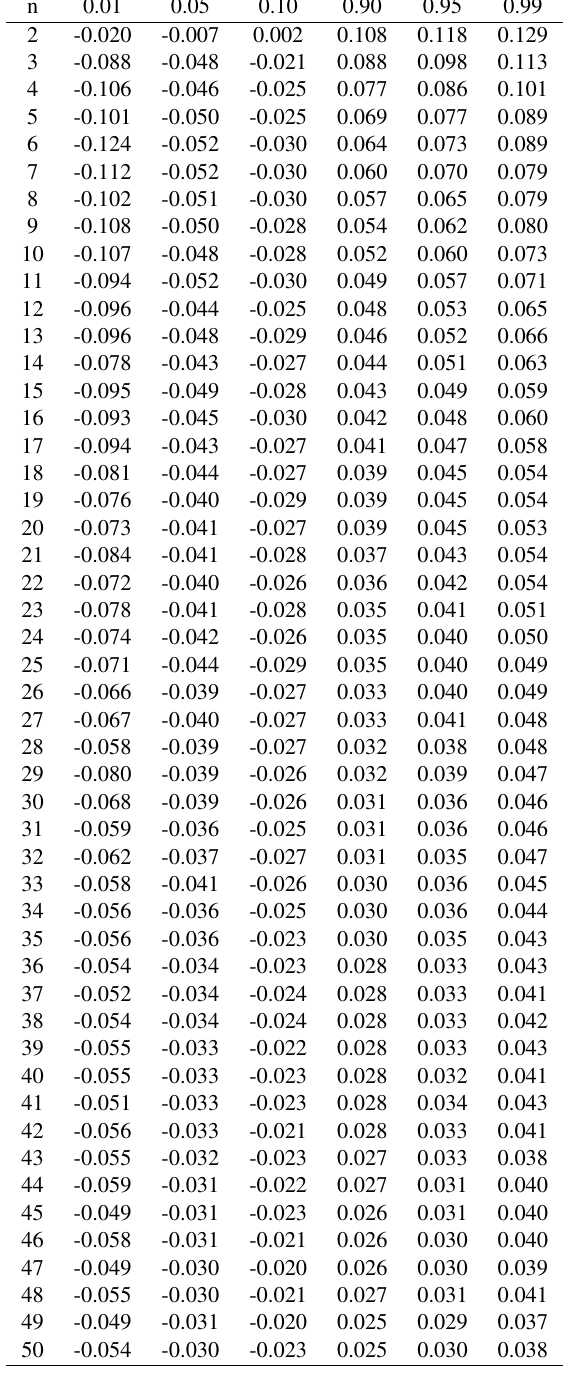
Table 2. Critical values of statistic ˆ δ 1 n ( λ ) at λ = 0 .